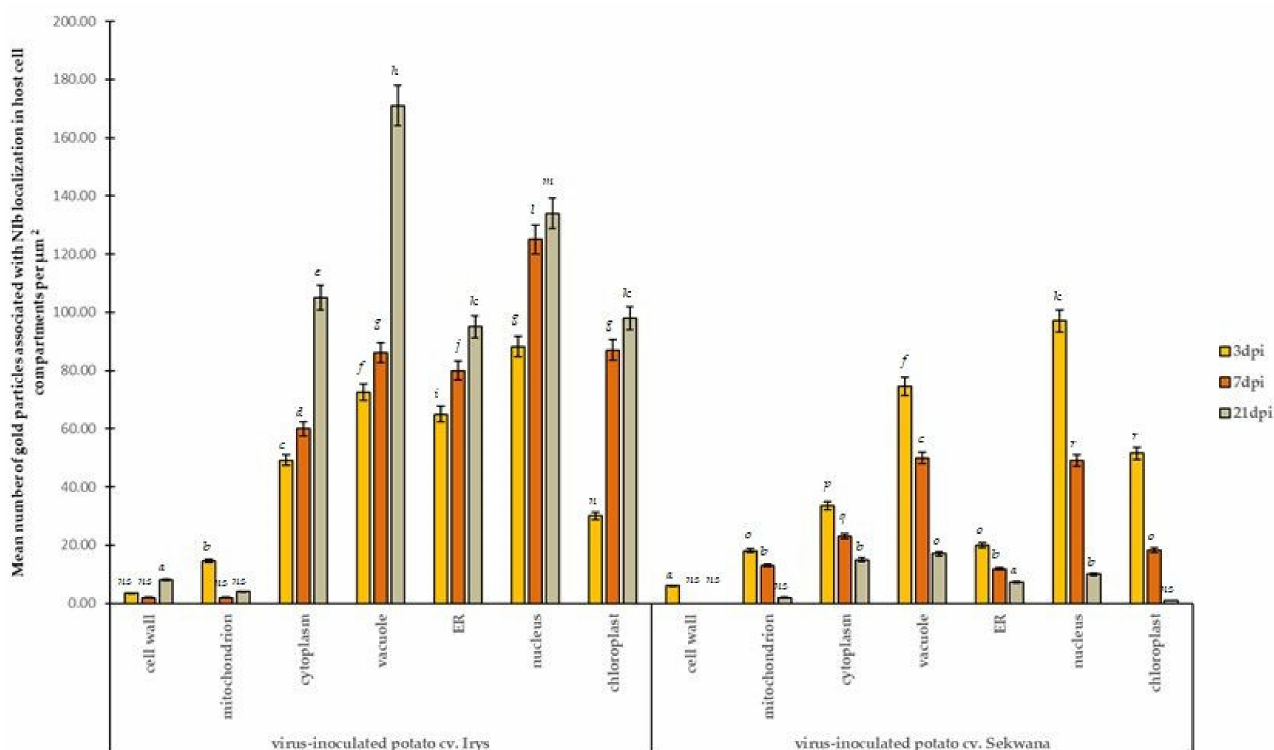
Figure 7. Statistical significance of PVY NTN -NIb immunogold localization in mock- and PVY-inoculated Irys and Sek- wana. The figure presents the mean number of gold particles localized in specific compartments per µ m 2 at 3, 7, and 21 dpi in mock- and virus-inoculated leaves. Quantification of immunogold localization was performed using ANOVA. The mean values were calculated at p < 0.05 with the post hoc Tukey’s HSD test. Statistically significant values are marked with letters above the bars. Nonsignificant values are marked as ns